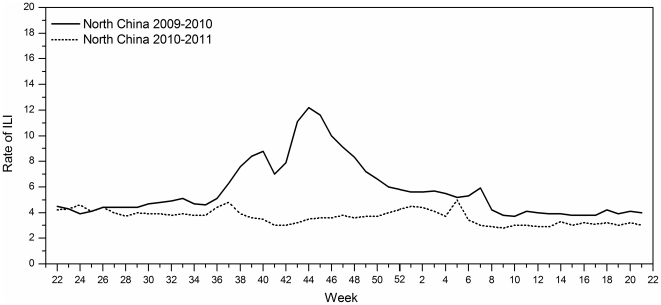
ILI rates in North China from June 2009 to May 2010 and June 2010 to May 2011.The weekly ILI rate increased rapidly in the 35th week of 2009 in North China, with the highest weekly ILI rate of 12.1 cases per 100 consultations occurring in the 44th week. However, the rate was relatively stable on the basis of the weekly ILI surveillance system of North China in 2010. The incidence rose slightly in January 2011 and the usual influenza seasonal peak appeared in the 5th week of 2011. The percentage of patient visits for ILI peaked at 5.0% in the influenza 2010–2011 season. ▴The ILI rate of North China derived from data obtained from the Chinese National Influenza Center (CNIC).